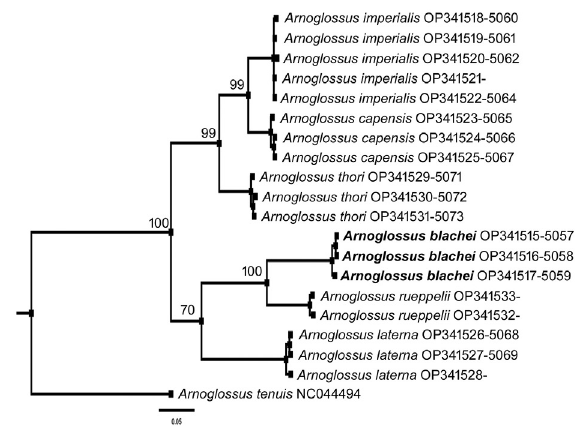
Fig. 12. – Phylogenetic relationship based on Bayesian inference for mitochondrial concatenated fragments ( 12s rRNA + COI ) for Arnoglossus species studied here. Posterior probabilities are shown as percentages and are indicated near the nodes. The samples of A. blachei are indicated in bold face.